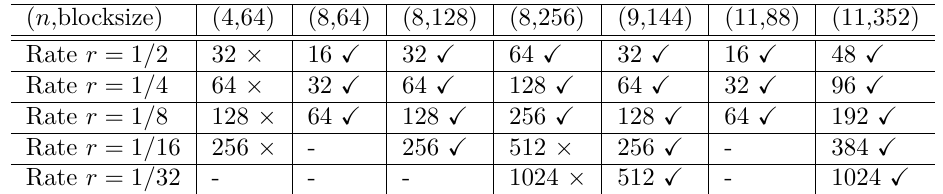
Table 2: Linear layers for P-SPNs: (in)applicability of our MDS code-based method. The numbers (which literally equal wr − 1 ) indicate the length of the MDS code required for the corresponding group of parameters, which is followed by either × meaning that linear layers cannot be constructed via our method & the explicit constructions of [MS77, Theorem 9], or (cid:88) otherwise. “-” means the group of parameters is meaningless due to rw < 1. ( n